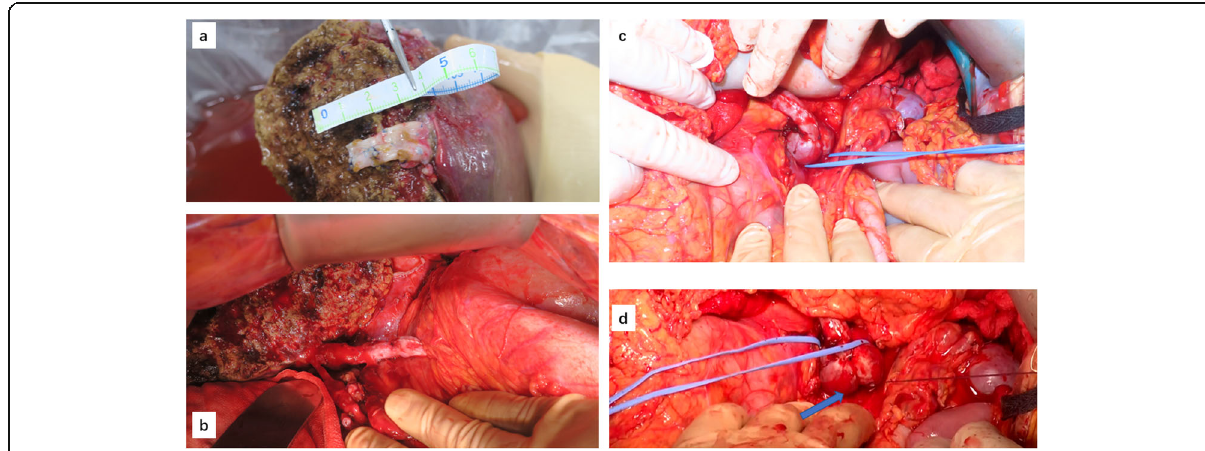
Fig. 3 The PV reconstruction. a The posterior branch of the PV was anastomosed with a vein graft of the right HV from the explanted liver because of the short cuff of the PV. b The patient ’ s tubular graft GSV was anastomosed to the IMV. c The patient ’ s graft GSV was anastomosed to a vein graft of the right HV. d We performed ligation with string at the shunt from the splenic vein to the renal